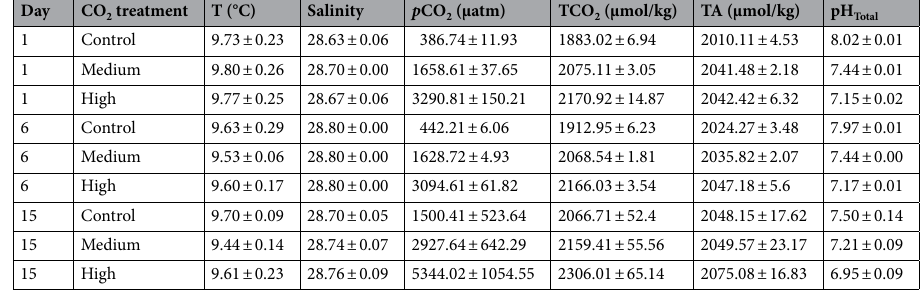
Table 1. Mean water parameters for each treatment (mean of 3 tanks ± S.D.) at the beginning (day 1, 2021-03- 06) and end (day 6, 2021-03-12) of embryonic incubation and mean parameters in the jars (N = 9) at the end of larval incubation (day 15, 2021-03-19); Temperature (T), salinity, p CO 2 , total CO 2 (TCO 2 ) measured at distinct sampling intervals with the BoL; total alkalinity (TA) and pH (on the total scale) calculated with